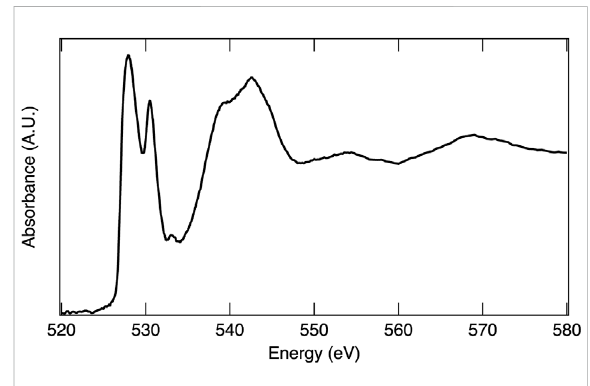
FIGURE 5 X-ray absorption spectrum of MnO 2 at the O K-edge.